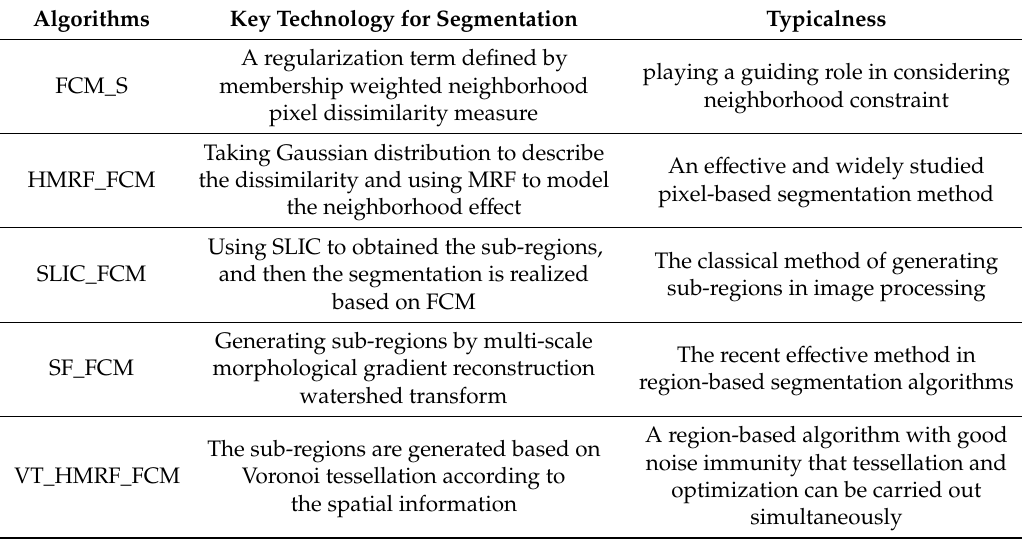
Table 1. The characteristics of comparing